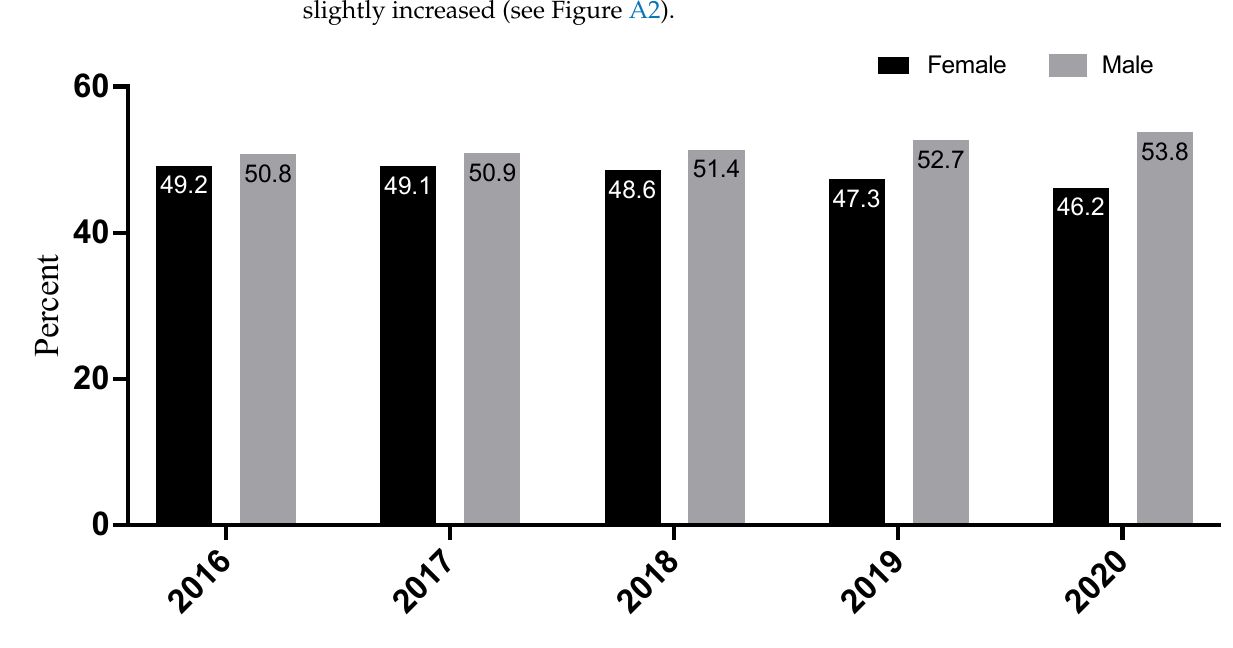
In terms of sex, the results of the men accounted for a slightly higher percentage (51.6%). Along with the successive stages of the study, the percentage of surveyed men slightly increased (see Figure A2).